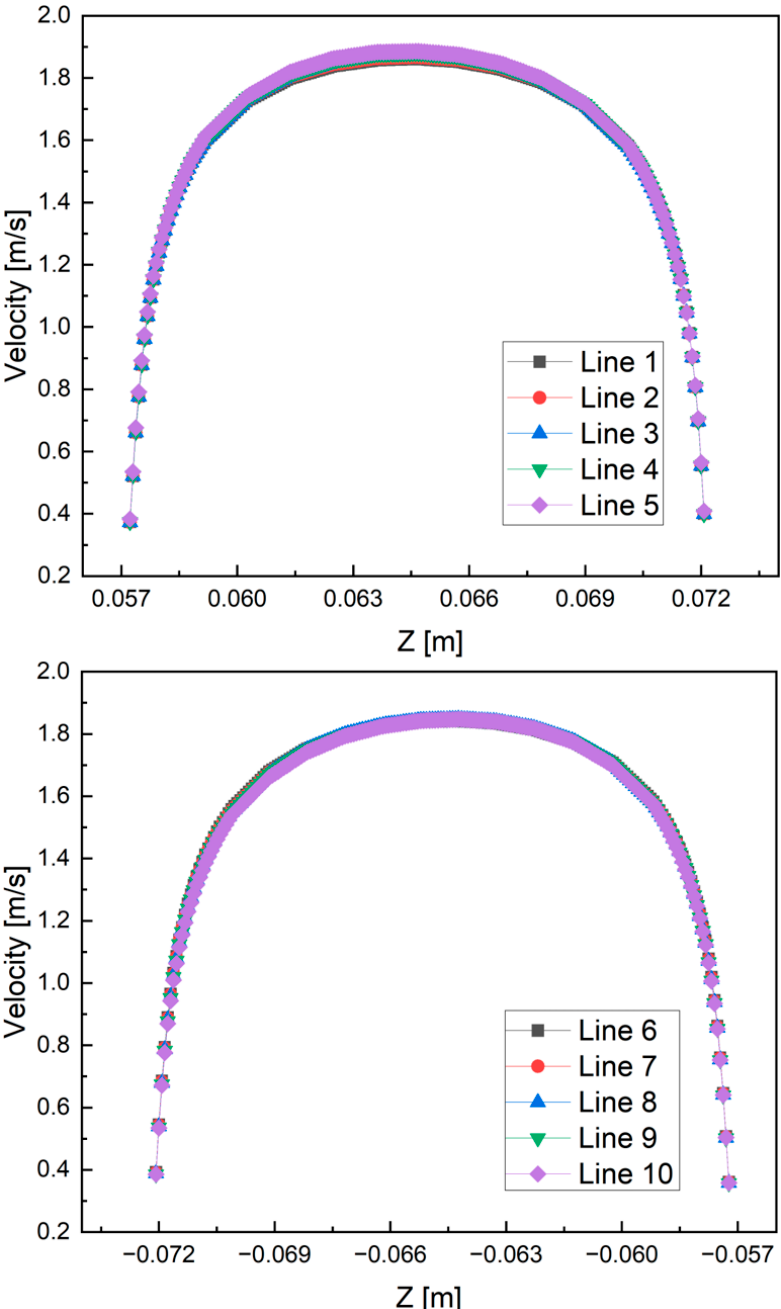
Figure 12. Velocity profile at lines 1–10.